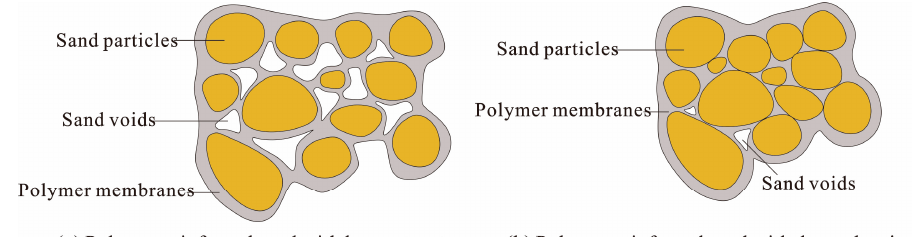
Figure 15. The mechanism of polymer-reinforced specimens with different dry density: ( a ) Polymer-reinforced sand with loose structure; ( b ) Polymer-reinforced with high density.